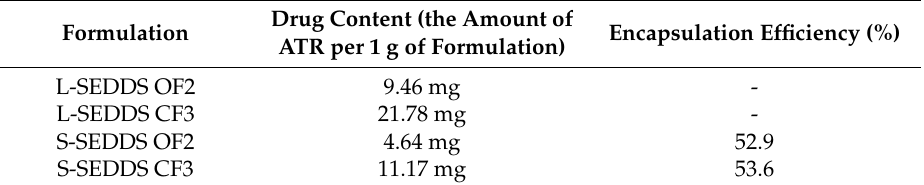
Table 6. Atorvastatin (ATR) content in liquid and solid SEDDS.